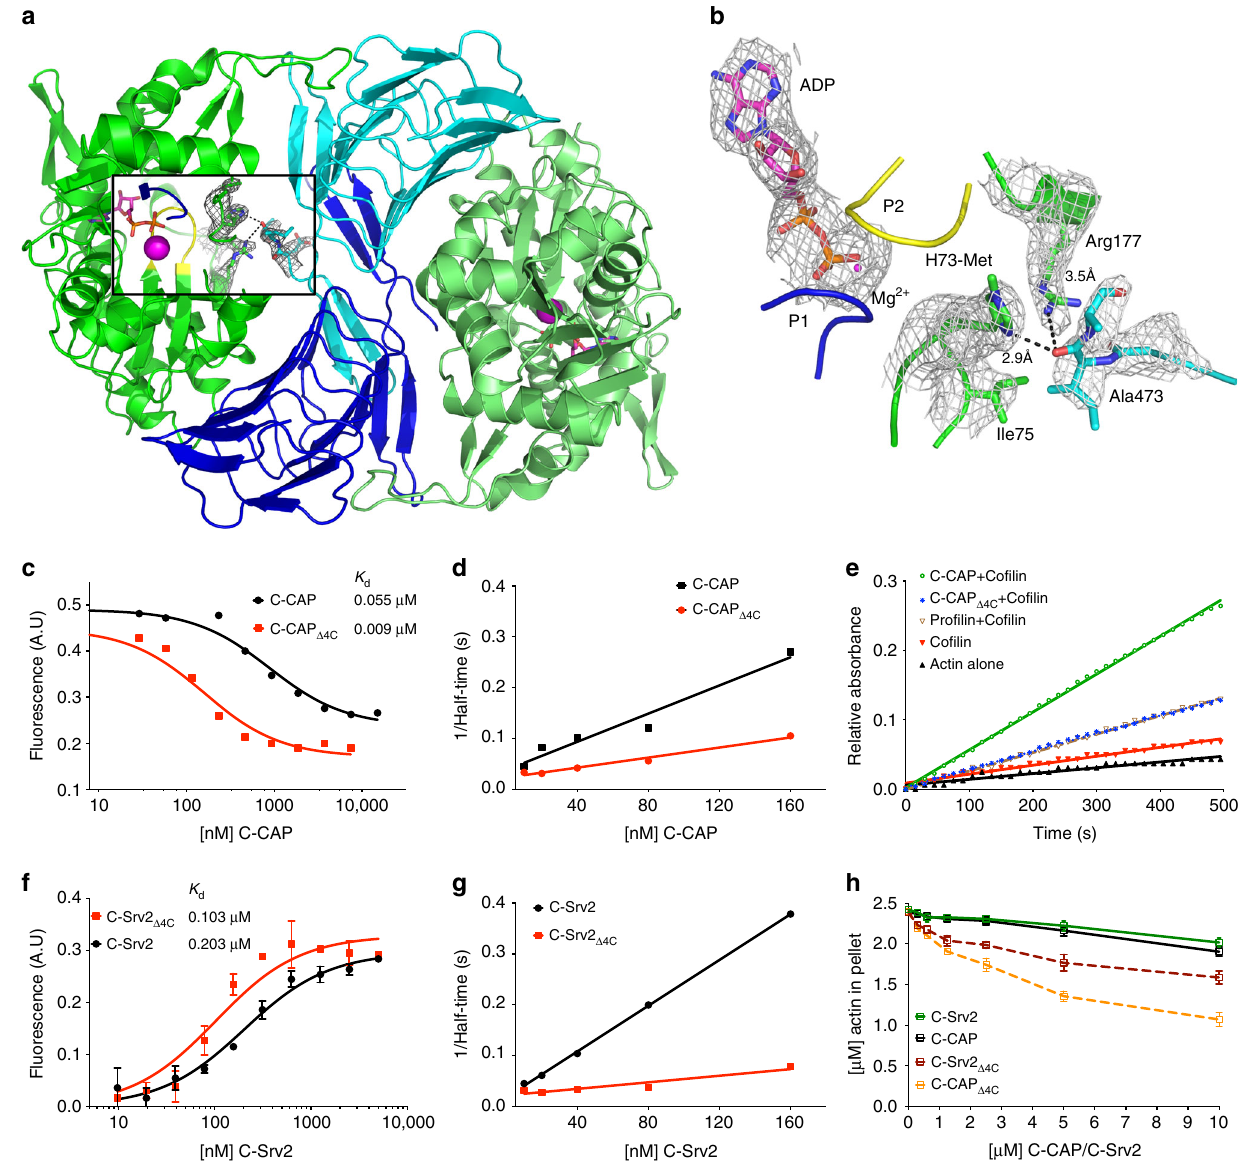
Fig. 4 The C-terminal tail of CAP is critical for nucleotide exchange. a C-terminal tail of CAP1 in the crystal structure displayed in 2 F 0 – F C ( σ = 1.0) electron density map. b Tail is positioned next to the nucleotide sensing region, loops P1 and P2 of actin that coordinate the nucleotide ( σ = 1.0 in 2 F 0 – F C electron density map). c The af fi nity of C-CAP and C-CAP Δ 4C for ADP-G-actin was determined by a fl uorometric competition assay with NBD-labeled actin (0.18 μ M) and the C-terminal ADF-H domain of mouse twin fi lin (0.44 μ M) (see Supplementary Fig. 4a). d A representative example of rate of ADP-G-actin (0.5 µ M) nucleotide exchange in the presence of different concentrations of wild-type C-CAP and C-CAP Δ 4C. e A representative example of actin fi lament turnover as followed by P i -release. F-actin (20 µ M) was mixed with the indicated proteins (each 5 µ M). f The af fi nity of C-Srv2